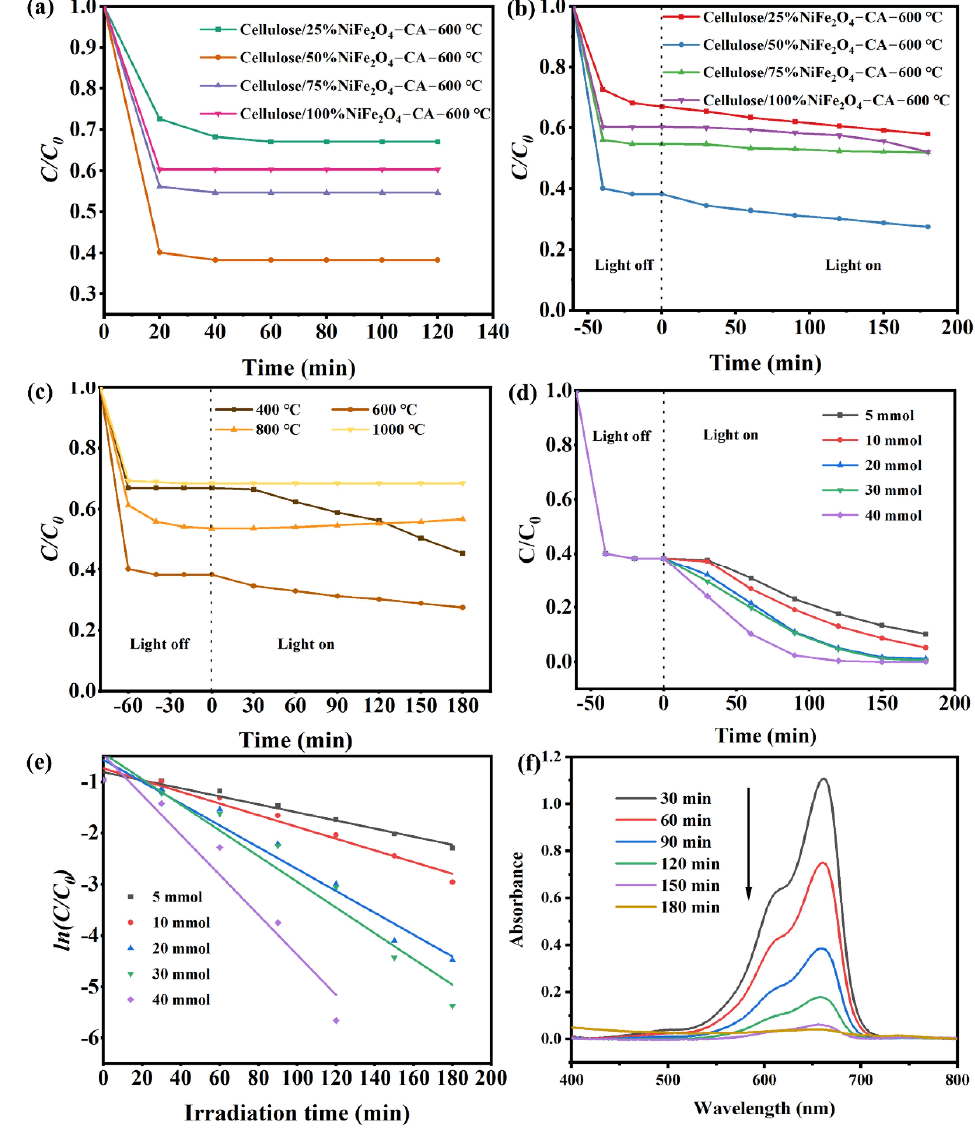
Figure 5. ( a ) Adsorption equilibrium curves under different loads. ( b ) Photodegradation curves under different loads ( C 0 = 20 mg/L, m(cellulose/50%NiFe 2 O 4 − CA − 600 °C) = 50 mg). ( c ) Effects of different calcination temperatures on photodegradation. ( d ) Effects of different dosages of H 2 O 2 on photodegradation., ( e ) Kinetic curves of different H 2 O 2 dosages. ( f ) UV-visible absorption spectrum